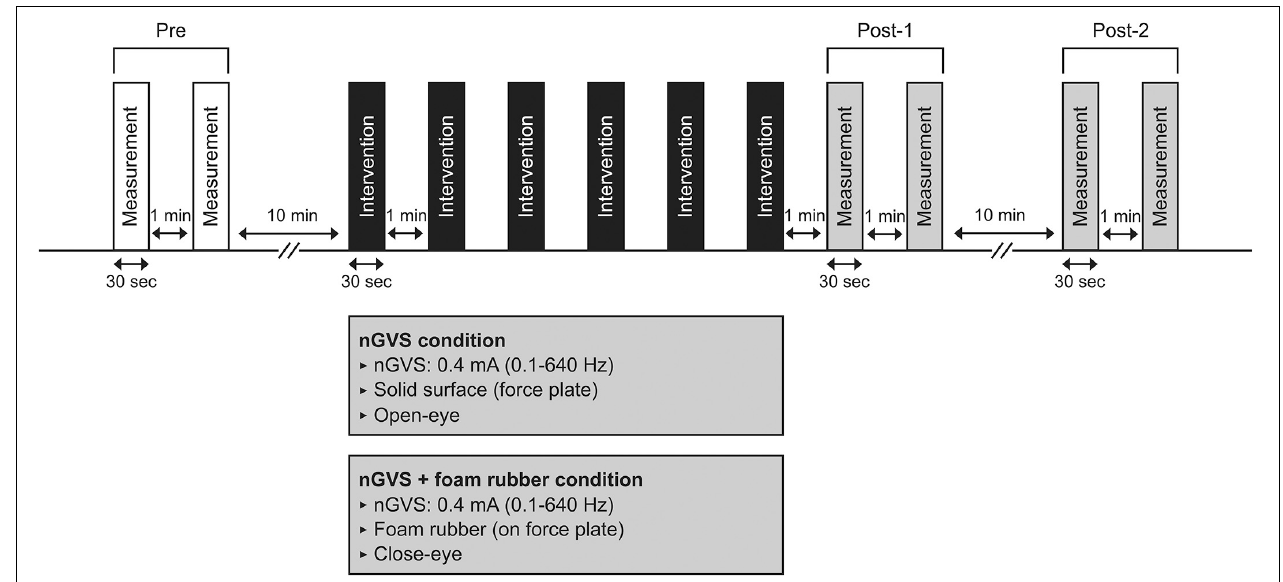
FIGURE 1 | Experimental 1 procedure. Participants underwent COP measurements (30 s) at pre, post-1, and post-2. Interventions in either condition (30 s × 6 times) were performed between pre and post-1.